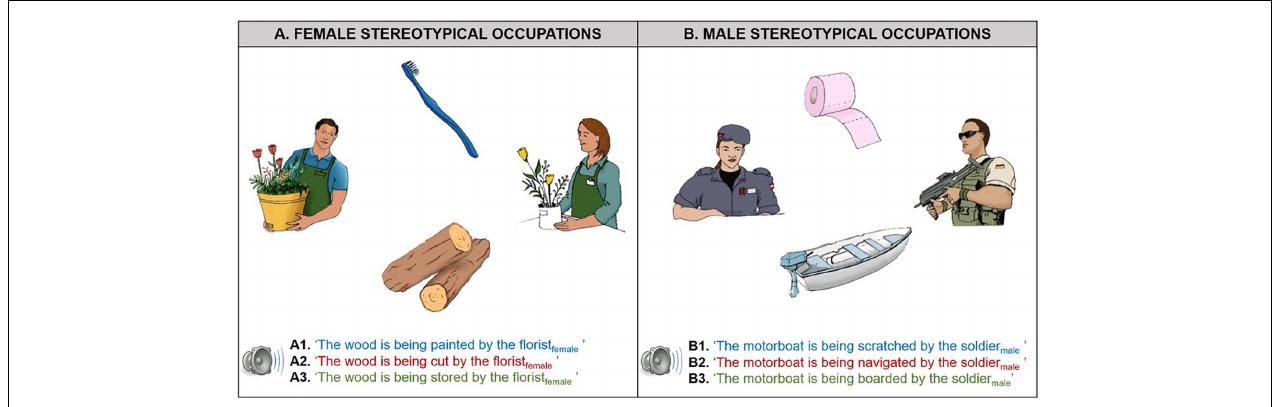
FIGURE 1 | Visual context example as a function of visually derived gender stereotypes ( A , female-stereotypical occupations; B , male-stereotypical occupations), as well as the corresponding verbally conveyed gender stereotypes ( 1 . female-stereotypical actions in blue font; 2 . male-stereotypical occupations in red font; 3 . neutral in green font). On each trial, participants saw a visual context with either female- or male-stereotypical occupations and heard one out of three possible types of sentences. The objects (e.g., wood, motorboat) and the characters (e.g., florist female , soldier male ) were always kept the same within an experimental item, while the sentential verb determined the gender stereotypical